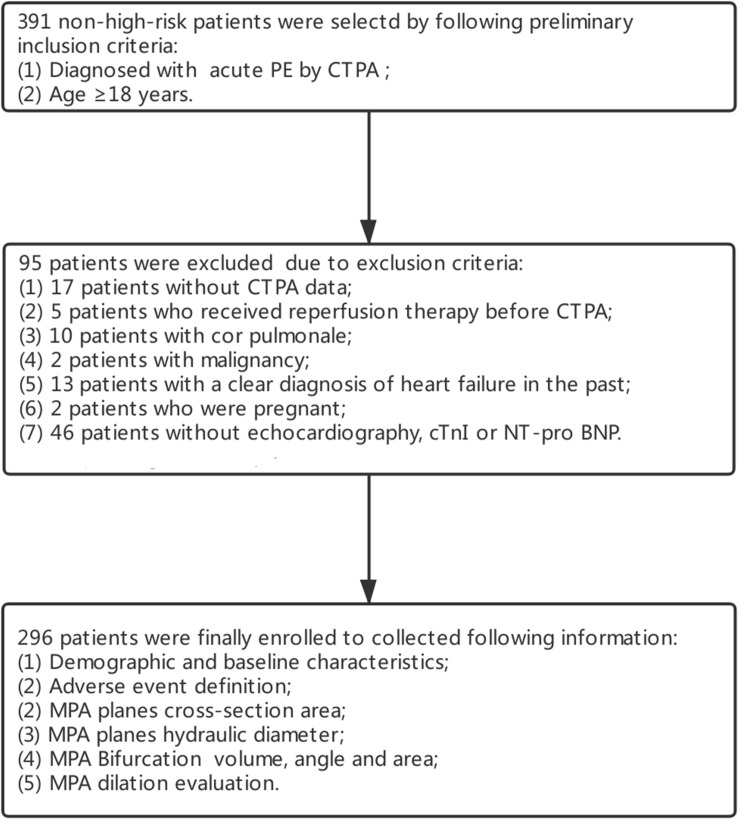
Flow chart of patient inclusion and exclusion.